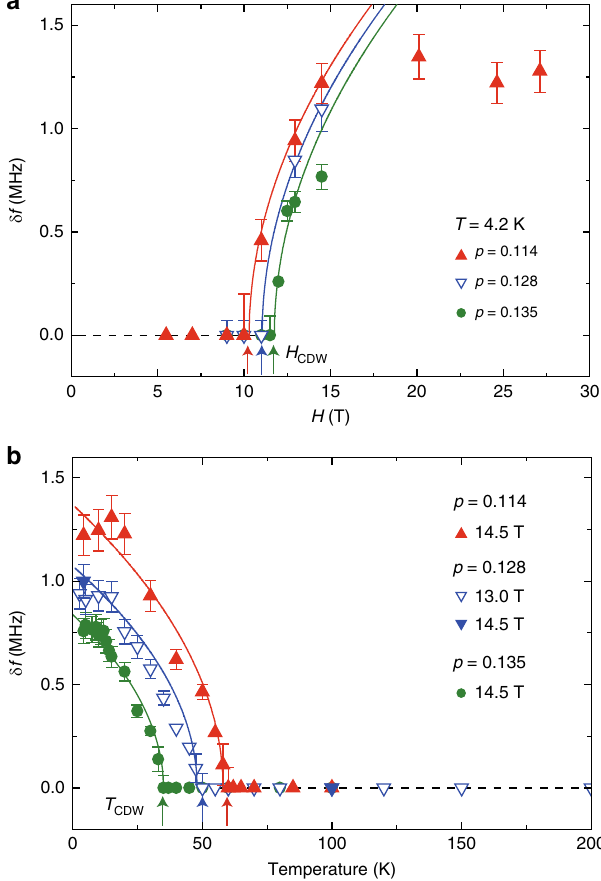
Fig. 4 Doping dependence of H CDW and T CDW . a H dependence of δ f at T = 4.2 K. From fi tting (solid curves) the data to a mean fi eld model, δ f ∝ ( H − H CDW ) 0.5 , the threshold fi eld for H -induced CDW, H CDW = 10.4, 11.0, and 11.8 T for p = 0.114, 0.128, and 0.135, respectively, was determined. b Temperature dependence of δ f for the three samples, from which the CDW onset temperature T CDW = 60, 50, and 35 K for p = 0.114, 0.128, and 0.135, respectively, was determined. The curves are fi ts to a mean fi eld model, δ f ∝ ( T CDW − T ) 0.5 . The dotted horizontal lines are guides to the eyes. Error bars represent the uncertainty in estimating δ